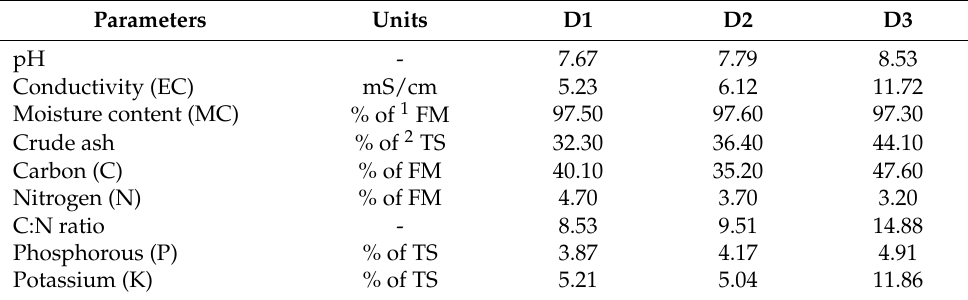
Table 6. Physio-chemical properties of AD